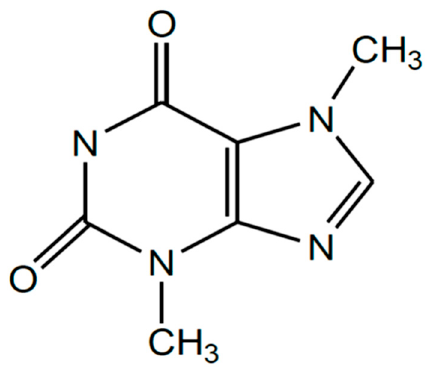
Figure 1. Chemical structure of theobromine [4].